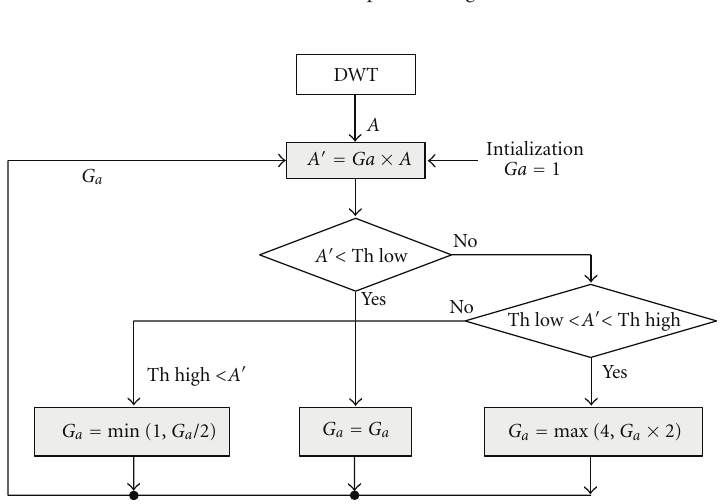
Figure 6: Binning coe ffi cient adaptive gain